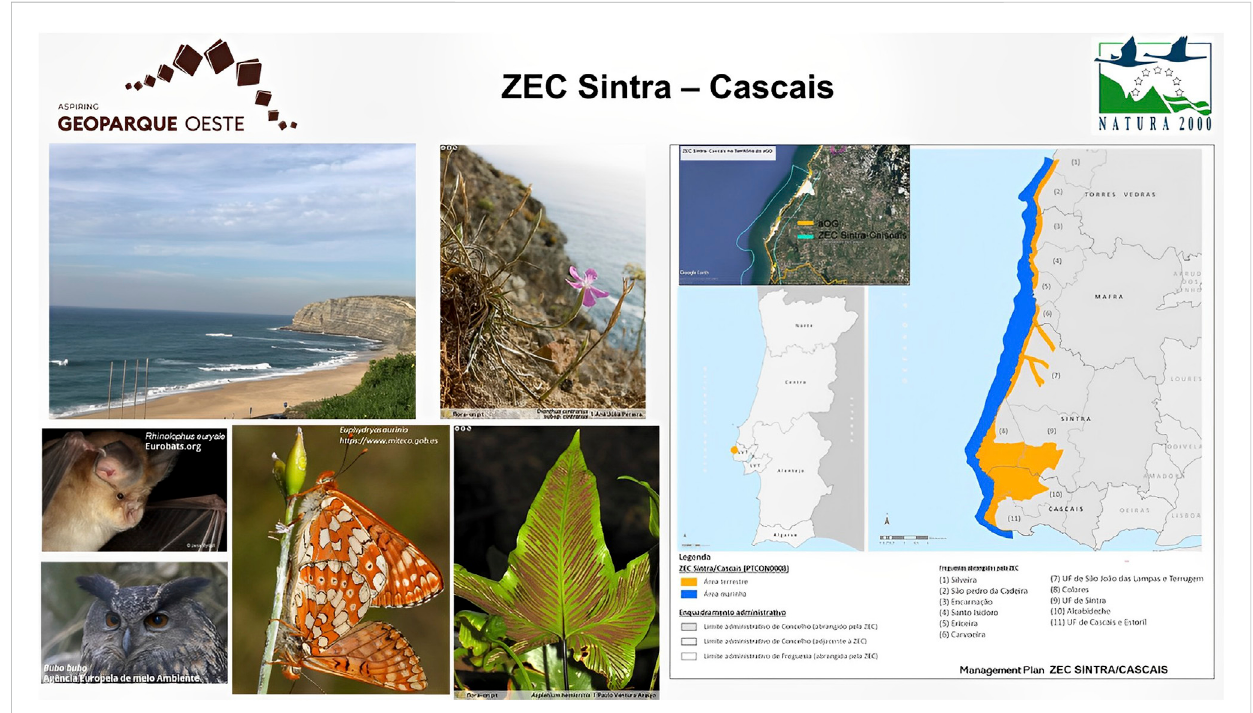
FIGURE 6 Sintra-Cascais special conservation area. Source: produced by the authors.